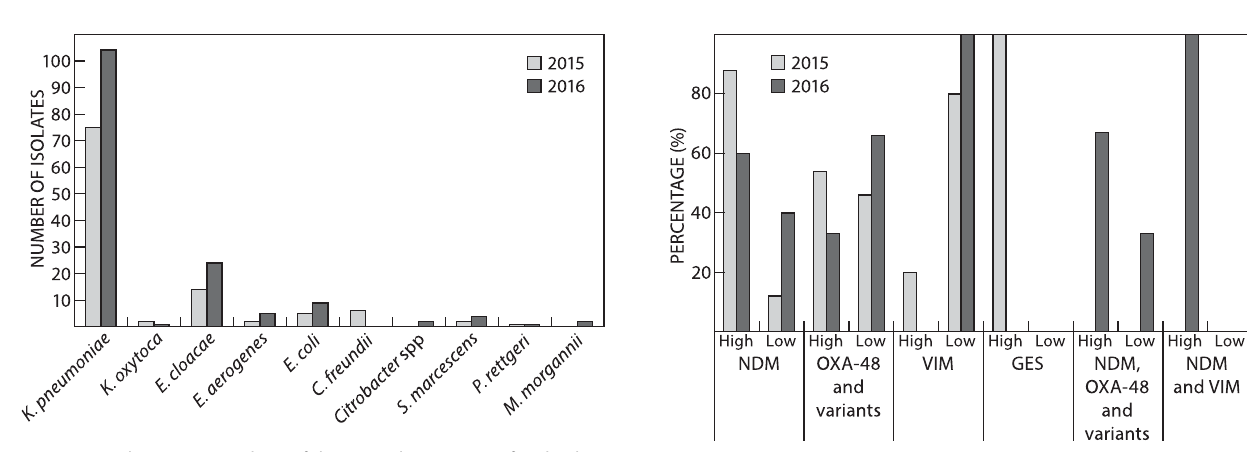
Figure 5: Carbapenemase and level of